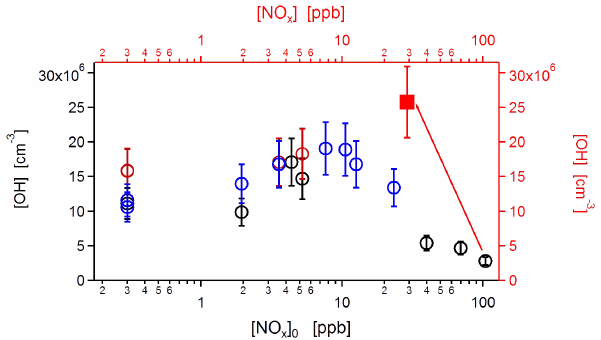
Fig. 7. PM max normalized to [BVOC] 0 = 65µgm − 3 in depen- dence of BNR assuming incremental mass yield of 0.117. Solid circles show data from experiments with NO x addition; open cir- cles are from experiments without NO x addition. The error in PM MAX ,norm is mainly due to the extra- and interpolations to [BVOC] 0 = 65µgm − 3 and estimated to ± 12%. The black lines show the average ± 1 σ standard deviation (upper/lower line) of the data without NO x addition. For comparison P(O 3 ) is shown (blue squares) as in Fig. 5. For one of the experiments (BNR = 4.3, [NO x ] 0 = 23ppb) PM MAX was not available. Therefore the num- ber of data in Fig. 7 include one less than in Fig.